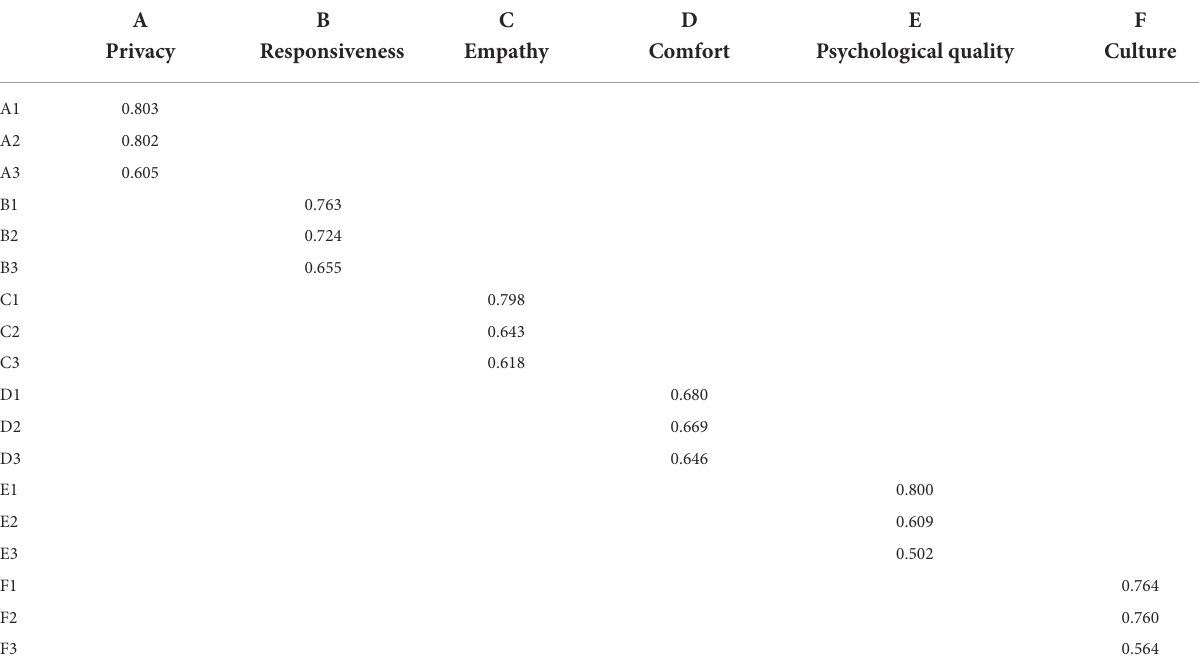
TABLE 5 Factor loadings for each item of the FS